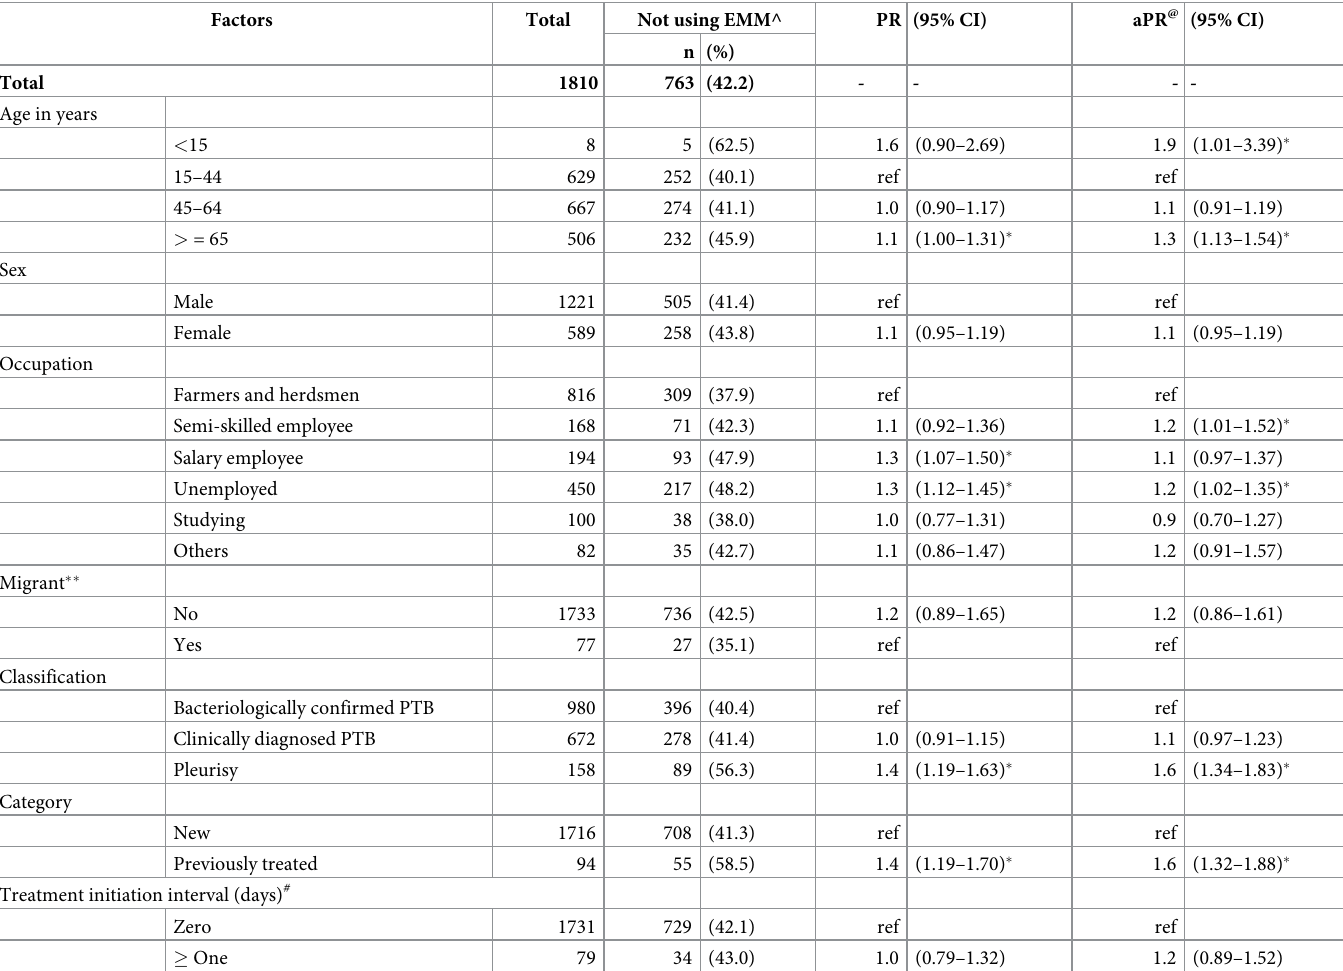
Table 2. Factors associated with not using EMM^ within first month of diagnosis among eligible notified people with TB in the 30 selected counties of China between July and December, 2018^^. Factors